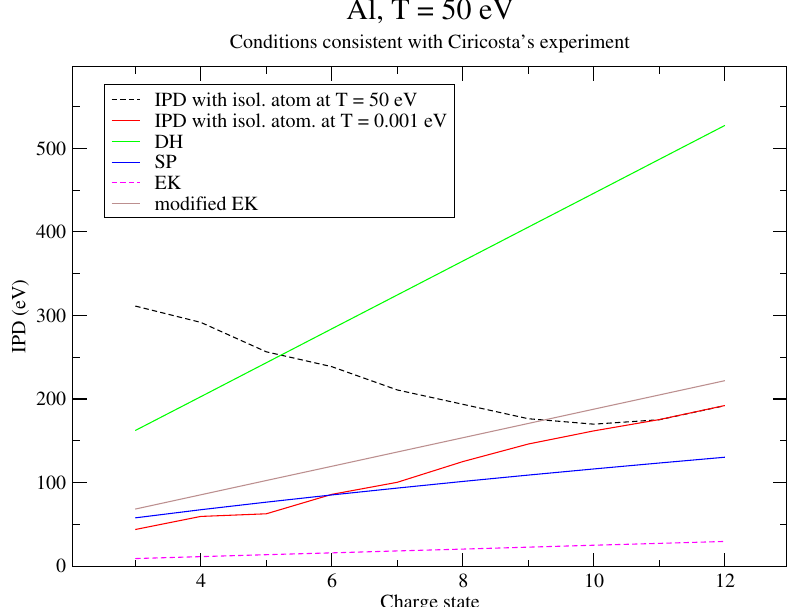
Figure 1. IPD of the different charge states for an aluminum plasma at T = 50 eV: our calculation (present work) with the isolated atom at T = 0.001 eV (red curve), Debye-Hückel model (green curve), Ecker-Kröll model (magenta dashed curve) and modified Ecker-Kröll model (brown curve). The dashed black curve represents the modification of the ionization potential when the isolated atom value is taken at the plasma temperature ( T = 50 eV). It does not correspond to the definition underlying the other approaches and is not an IPD stricto sensu .